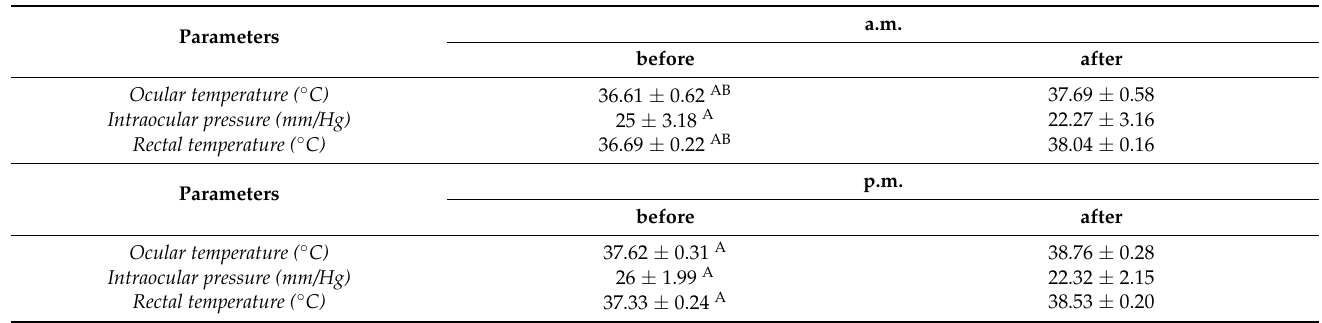
Figure 3. Linear regression values between ocular temperature and rectal temperature during the a.m. hours before and after exercise and between ocular temperature and rectal temperature during the p.m. hours before and after exercise. Linear regression analysis between ocular temperature and intraocular temperature during the a.m. hours before and after exercise and during the p.m. hours before and after exercise. Linear regression analysis between rectal temperature and intraocular temperature during the a.m. hours before and after exercise and during the p.m. hours before and after exercise. Table 1. Mean values ± SD of ocular temperature, intraocular pressure and rectal temperature, recorded before and after exercise during the a.m. and p.m. hours, together with their statistical significances. Capital letters (A vs. After; B vs. p.m. hours) indicate statistically differences between times and between experimental